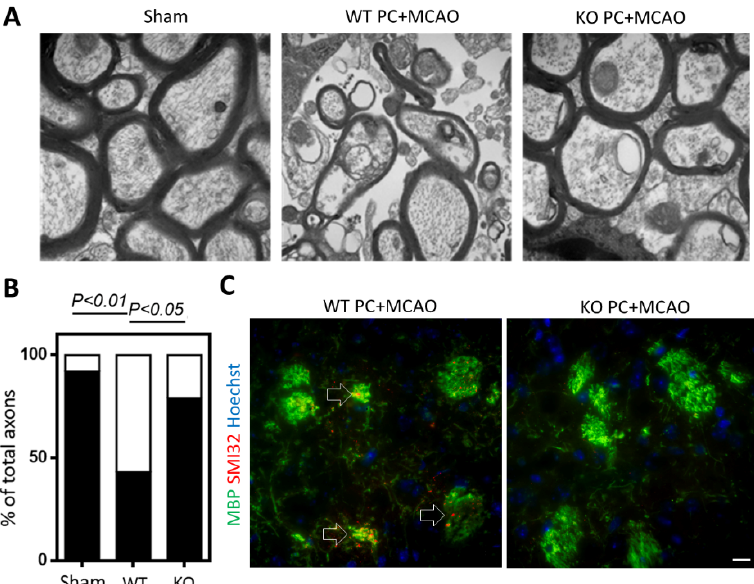
Figure 4. BNIP3 knockout rescues myelination defects after preconditioning. ( A ) Electron micro- graphs of myelinated axons in the infarcted corpus callosum. EM showed healthy myelinated axons in the control and damaged axons of varying size in the wild-type and BNIP3 KO mice. Note that more vacuolization and myelin debris could be identified in the wild-type preconditioning. ( B ) The percentages of the myelinated axon (black box) and demyelinated axon (white box) were quantified from electron microscopy. ( C ) Representative immunofluorescence microscopic analyses of MBP (green) and SMI-32 (red) in preconditioning treated wild-type and BNIP3 KO mice. Abnormal MBP distribution and dephosphorylated neurofilament SMI-32 could be detected in preconditioning treated wild-type mice. n = 3.